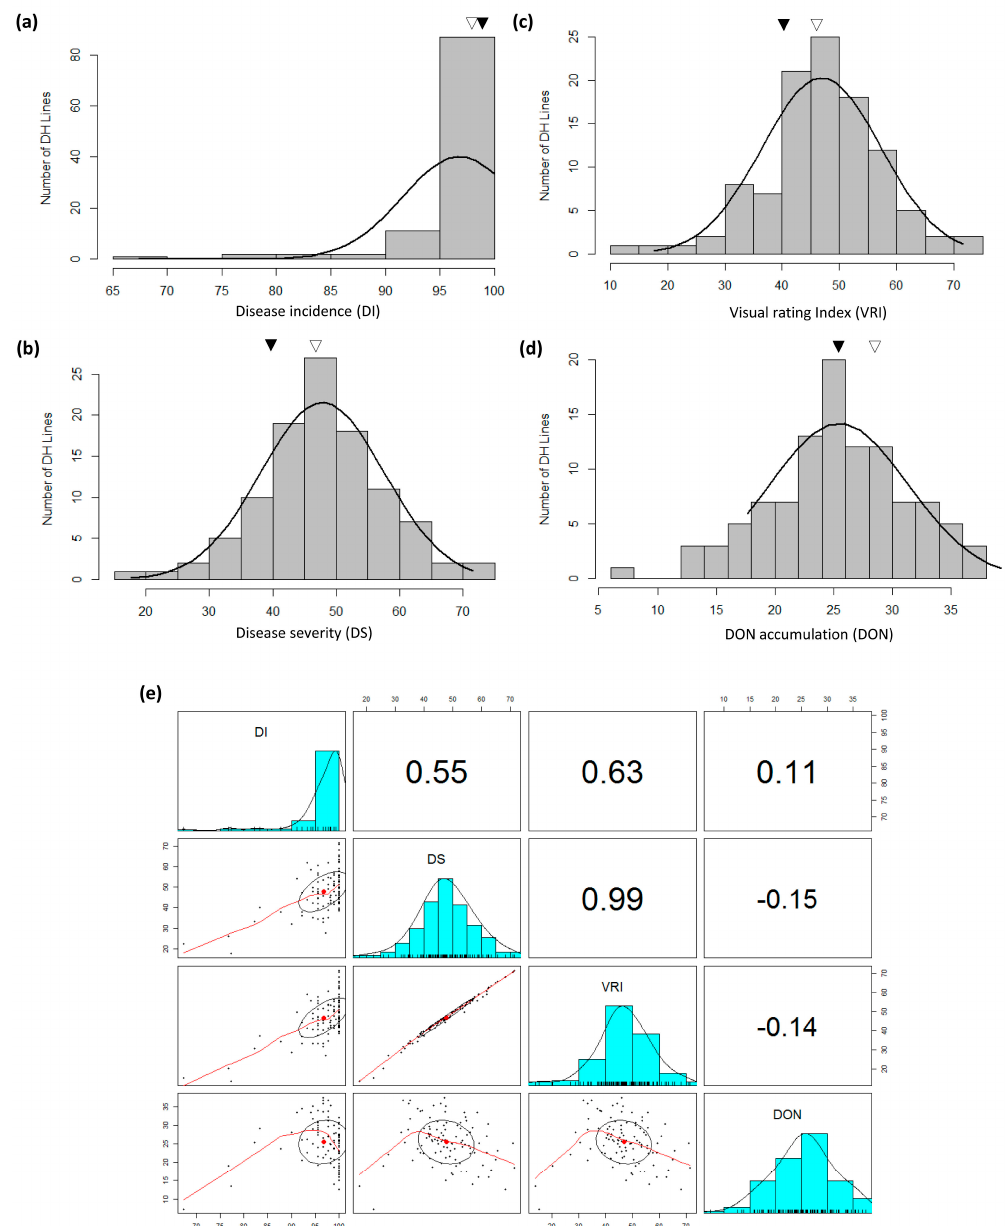
Figure 1. Frequency distribution of 100 doubled haploid (DH) lines of triticale genetic mapping population produced from a biparental cross between TMP16315 and AC Ultima for mean of four Fusarium head blight (FHB) traits namely: ( a ) disease incidence (DI, %), ( b ) disease severity (DS, %), ( c ) visual rating index (VRI, %) and ( d ) deoxynivalenol (DON, ppm) content evaluated at Beloeil. The means of the parental genotypes are indicated over graphs by triangles (AC Ultima, hollow triangle; TMP16316, solid triangle). ( e ) Scatterplot of above four FHB traits (DI, DS, VRI and DON) evaluated at Beloeil. Correlation coefficients (top diagonals) and regression line (lower diagonals) deciphered relationship among different traits studied.